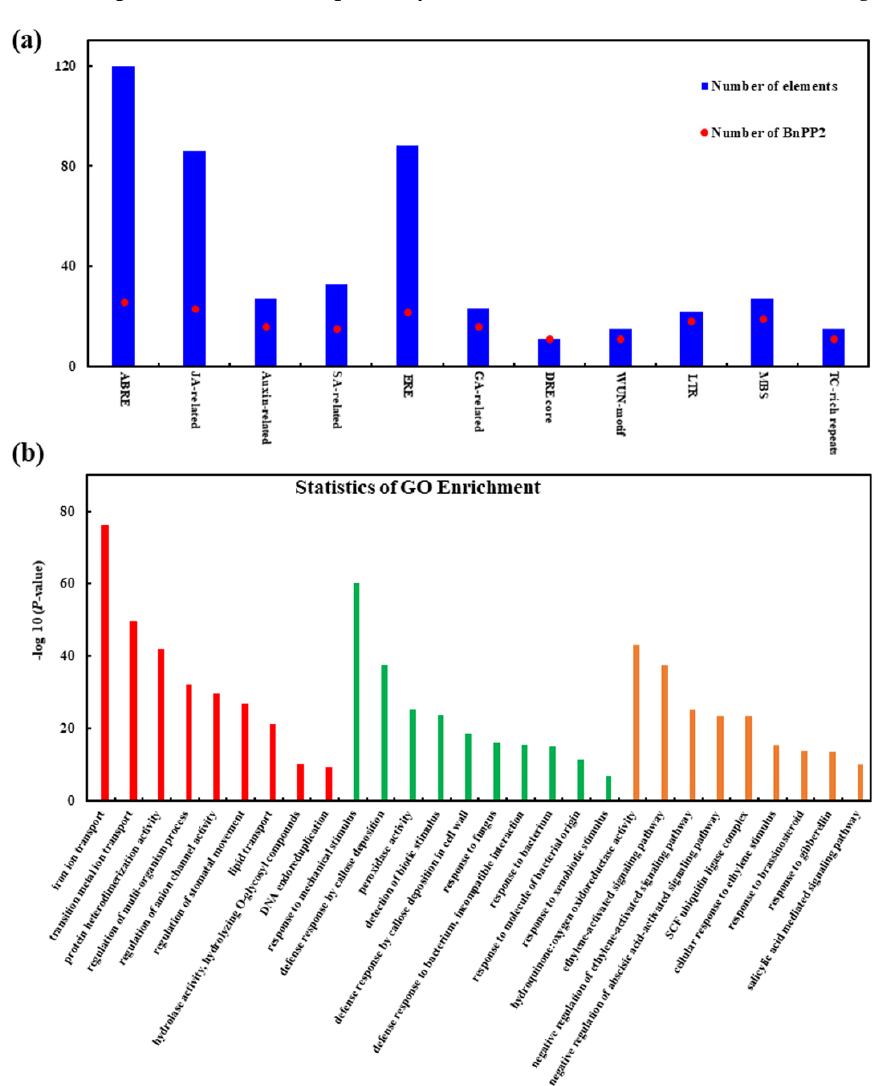
Figure 5. ( a ) The hormone-related and stress-related cis-acting regulatory elements in the promoters of the BnPP2 genes in clusters II–IV. The bar graph indicates the total number of each cis-acting element found in the BnPP2 promoters (royal blue box), as well as the number of BnPP2 promoters that included a specific cis-regulatory element (red circle). ( b ) The gene ontology enrichment analysis of proteins that interacted with BnPP2 proteins. Table S4 contains more detailed information.